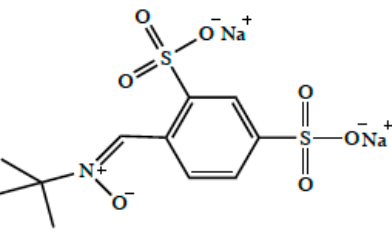
Figure 1. Chemical structure of disufenton sodium (i.e., NXY-059, Cerovive ® ).